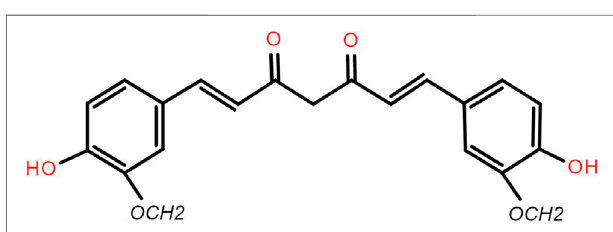
FIGURE 2 | Chemical structure of